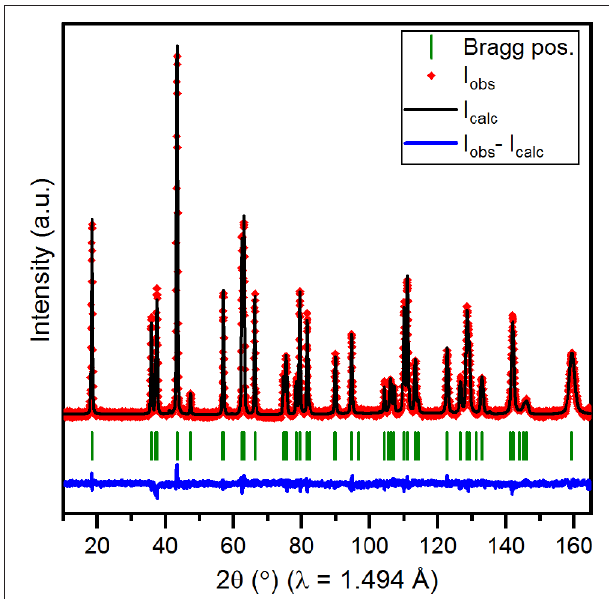
FIGURE 3 | Rietveld refinement profile obtained using the ex situ neutron diffraction pattern of the NCM622 pristine powder. The calculated profile (black) is superimposed on the experimental profile (red diamonds) and the difference curve is drawn in blue. The calculated Bragg positions of the diffraction peaks are indicated by green ticks.